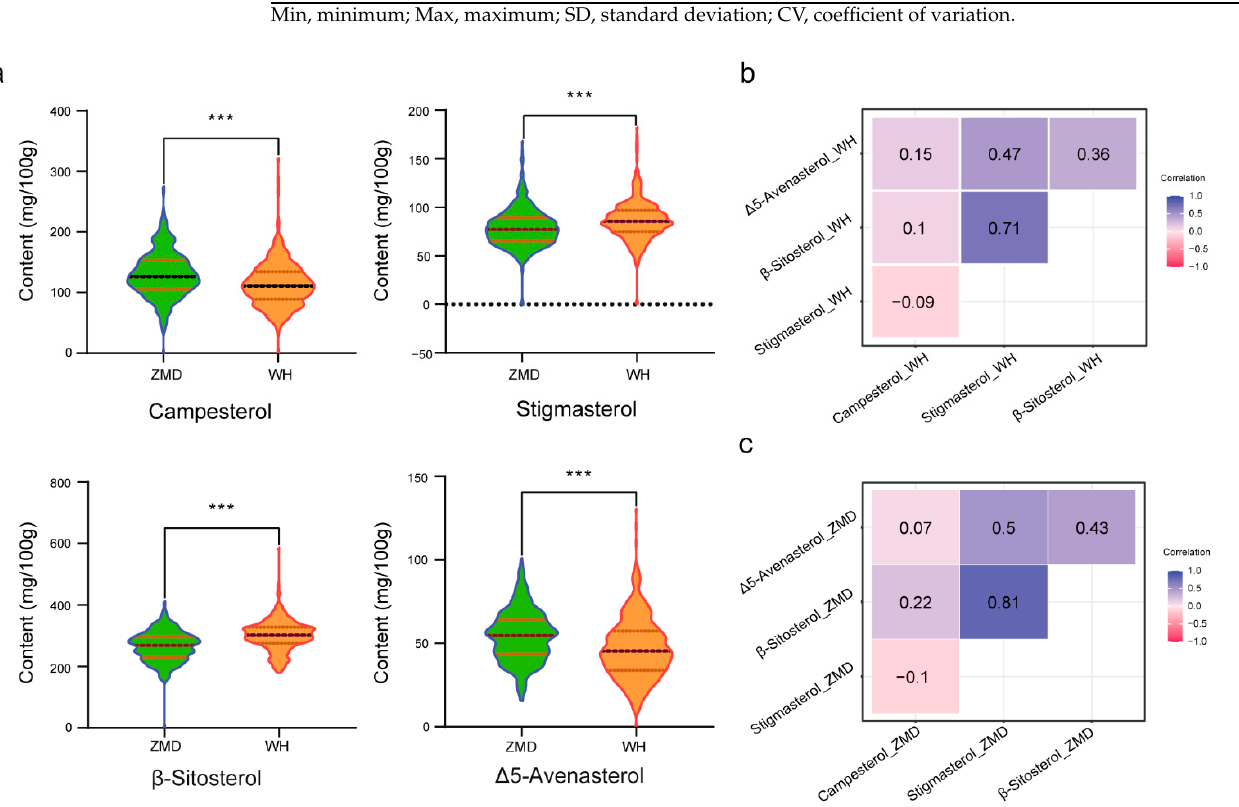
Table 1. Variation of primary phytosterol contents in sesame